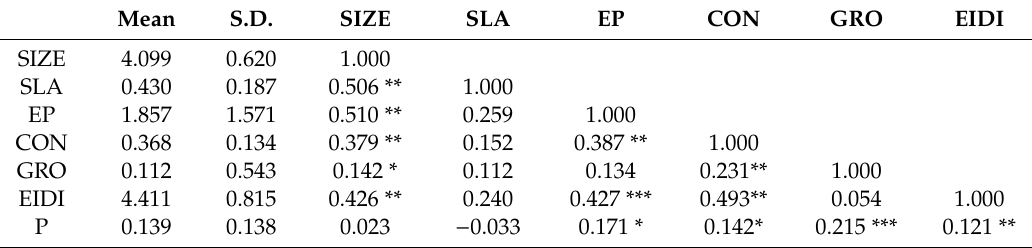
Table 1. Descriptive statistics of substantive-style firms.